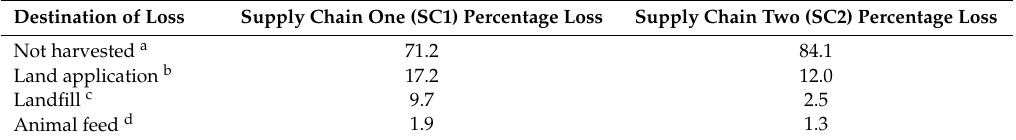
Table 4. Destination of loss.